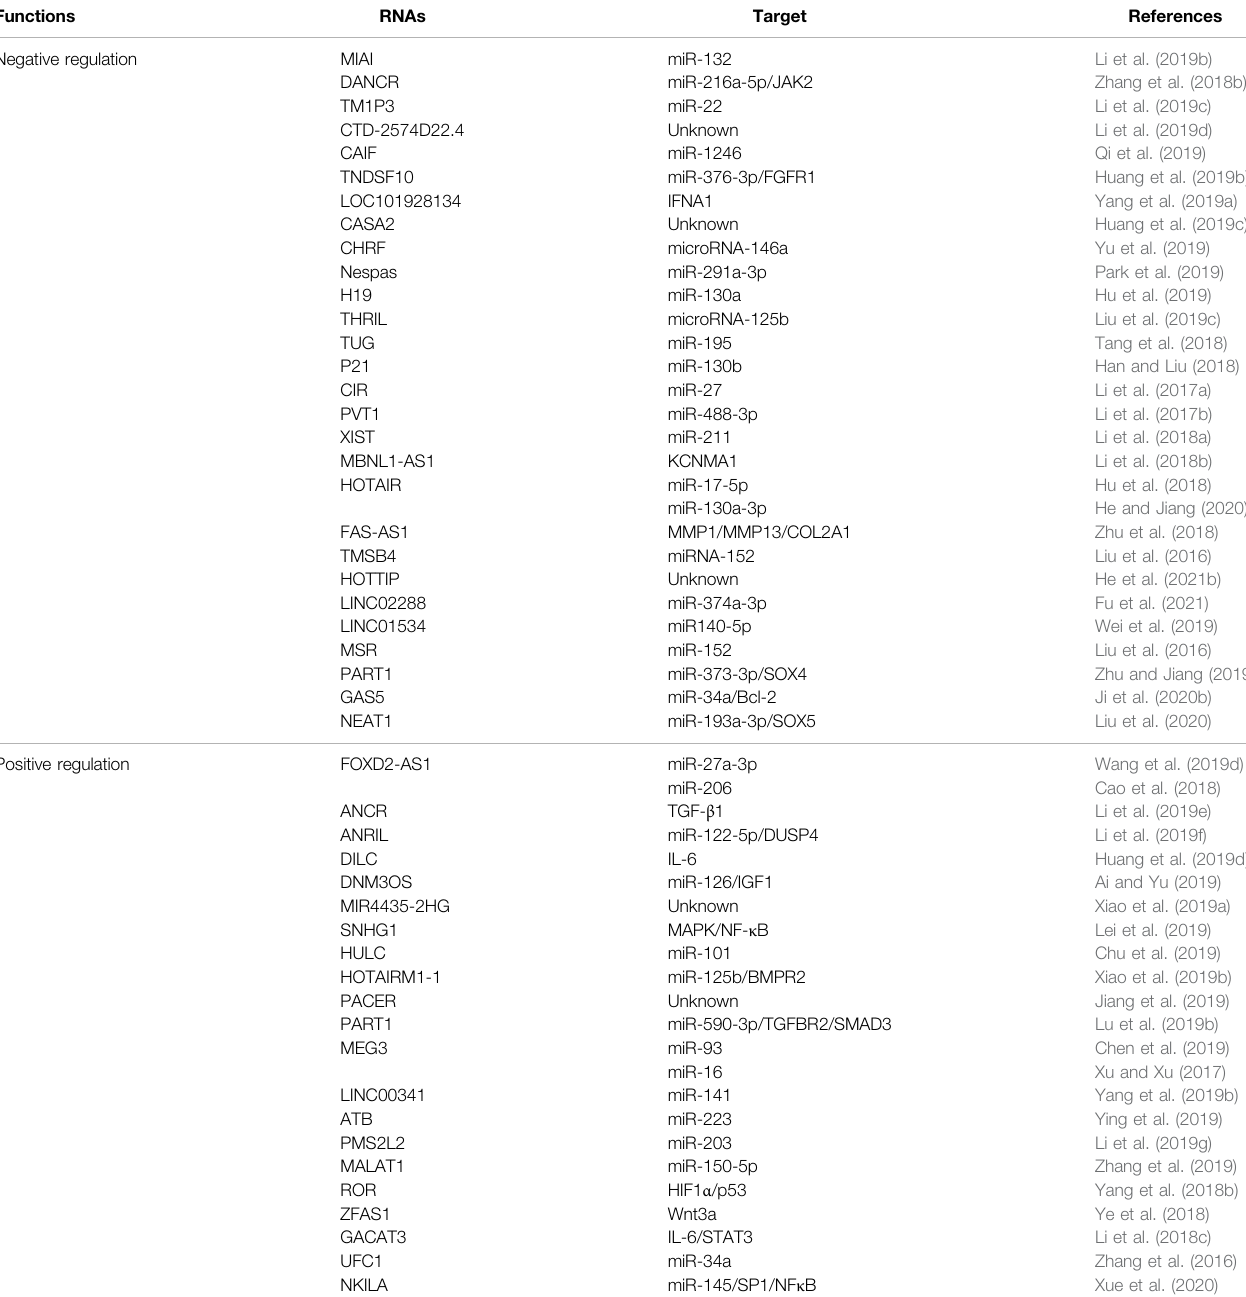
TABLE 2 | lncRNAs and the targets in osteoarthritis.